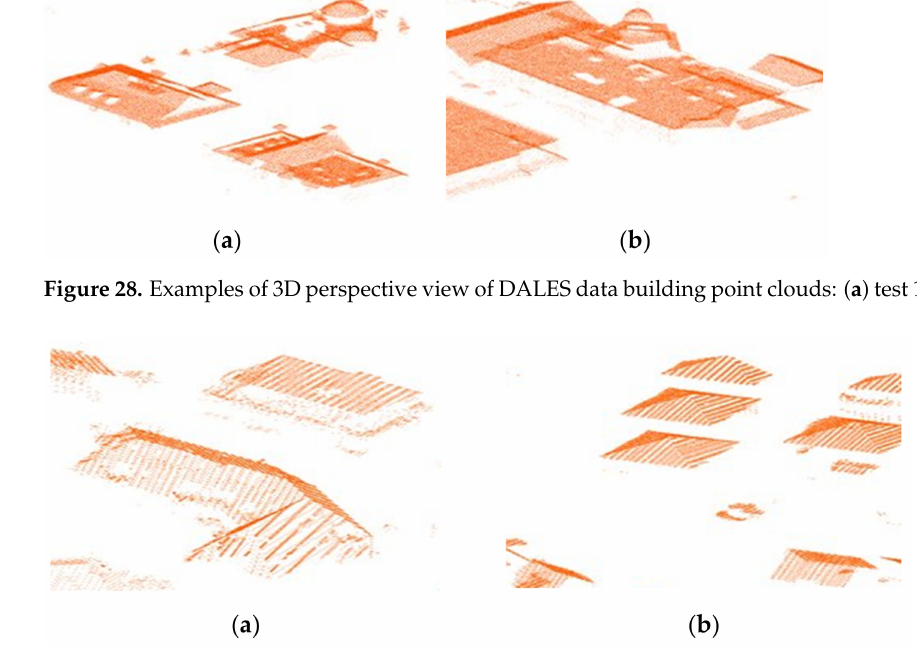
Figure 29. Examples of 3D perspective view of ISPRS Vaihingen building point clouds: ( a ) new 1; ( b ) new 2.